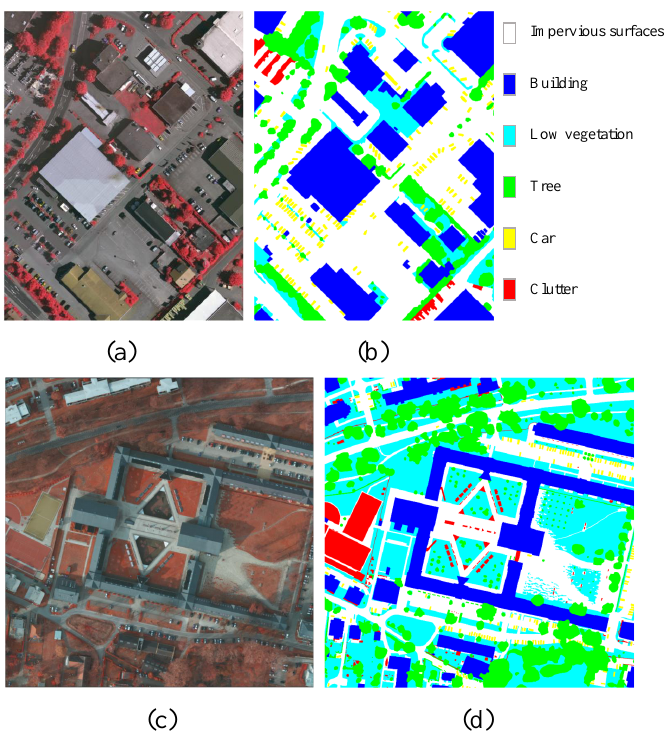
Figure 11. Examples of datasets. From left to right: ( a , b ) An original image and ground truth of Vaihingen dataset; ( c , d ) An original image and ground truth of Potsdam